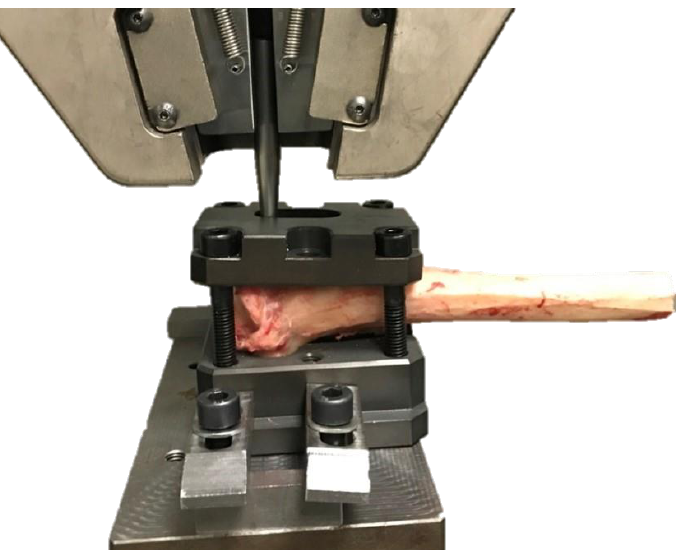
Figure 7. The tibia positioned in the testing machine. The jig with the proximal tibia was attached to the lower machine arm, and the bar was fixed in the upper frame of the electromechanical testing machine (MTS Insight 100 kN, Eden Prairie, MI, USA).